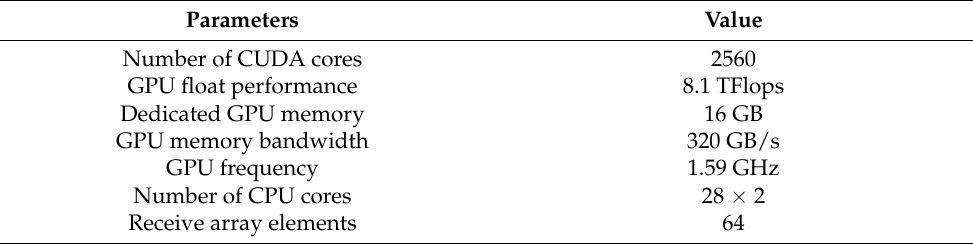
Table 2. Hardware specifications.